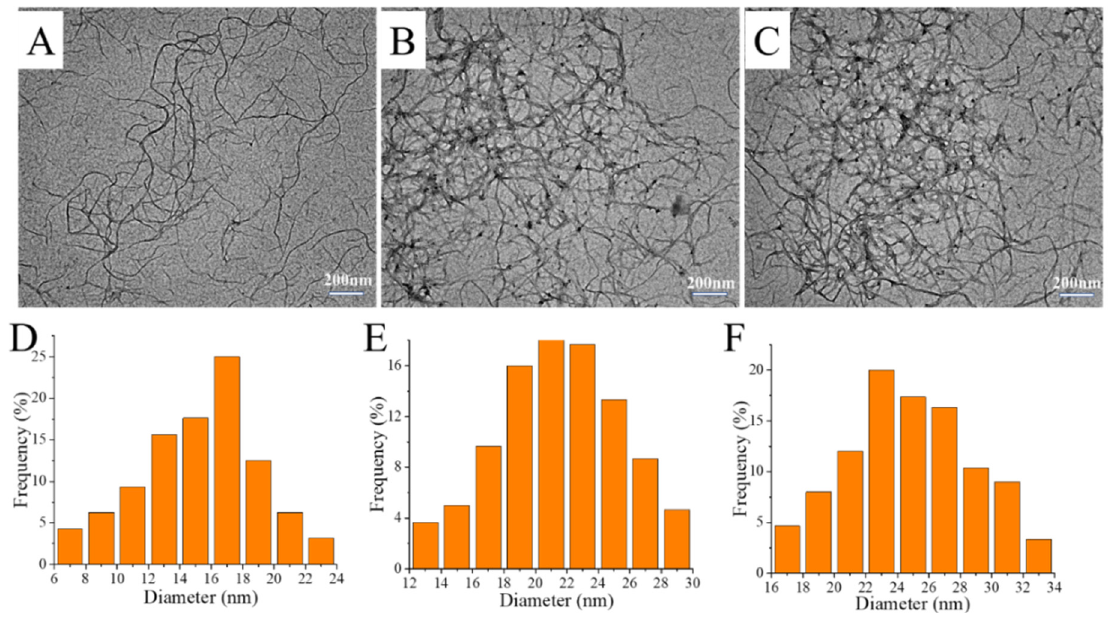
Figure 3. TEM images of deprotonated ( A ) ANFs in DMSO, ( B ) ANFs in water, and ( C ) TA@ANFs in water. Their respective diameter distributions are shown in ( D – F